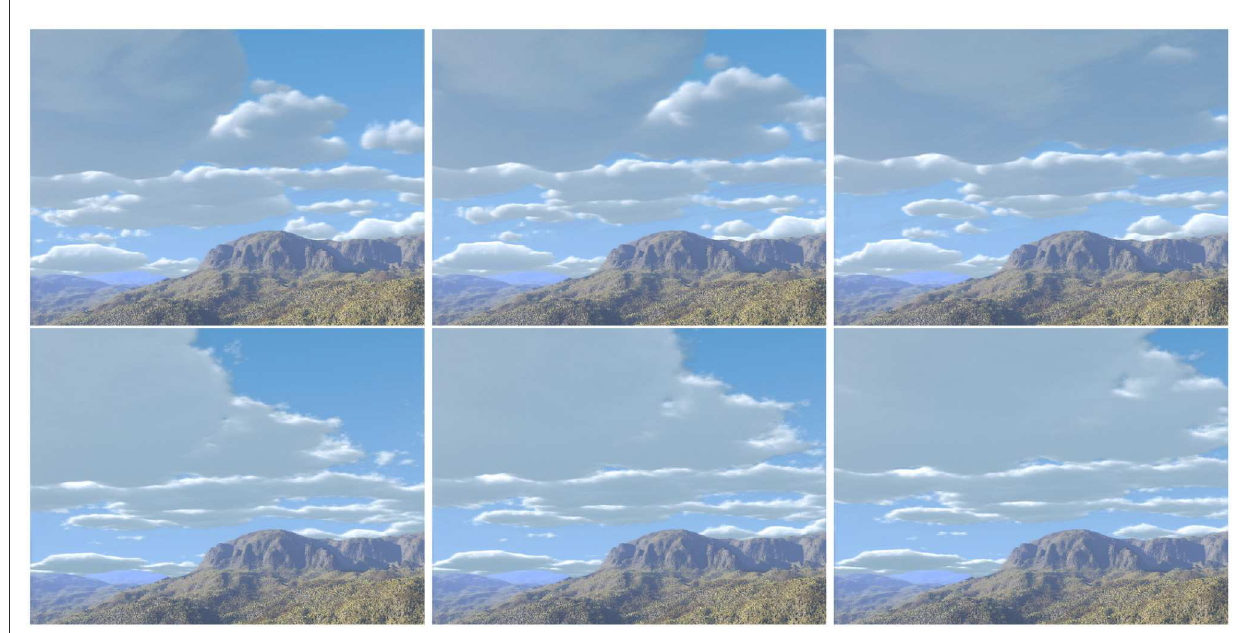
FIGURE13 Time-lapse of cloud evolution (high sky coverage) using (top) the proposed method and (bottom) the base method (Goswami, 2019). Each column represents a 15-s offset in time between adjacent columns, with time increasing from the left to the right .